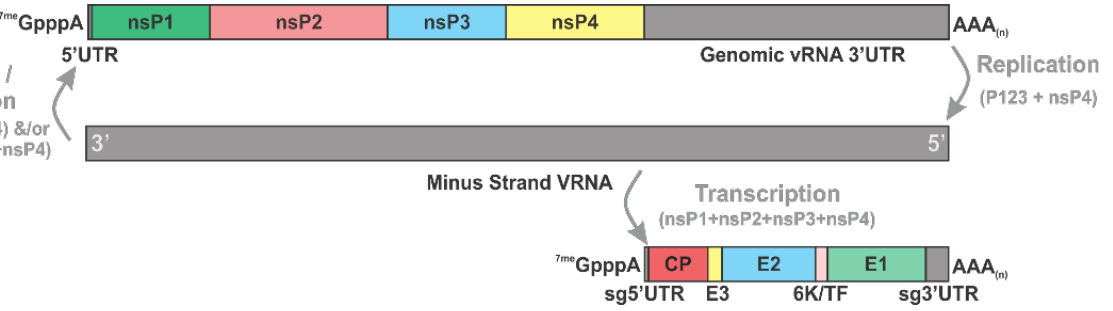
Figure 2. Organization of the Alphavirus Viral RNAs. Schematic diagrams of the coding organization of the SINV Genomic (top), Minus (middle), and Subgenomic (bottom) RNAs. The individual components of the nonstructural and structural polyproteins are indicated as are the untranslated regions (UTRs) and major features of the RNAs. Individual components are drawn to scale, relative to one another. Viral RNA synthetic processes responsible for the synthesis of each vRNA species, and the replicase complexes primarily responsible for their synthesis are shown in grey.